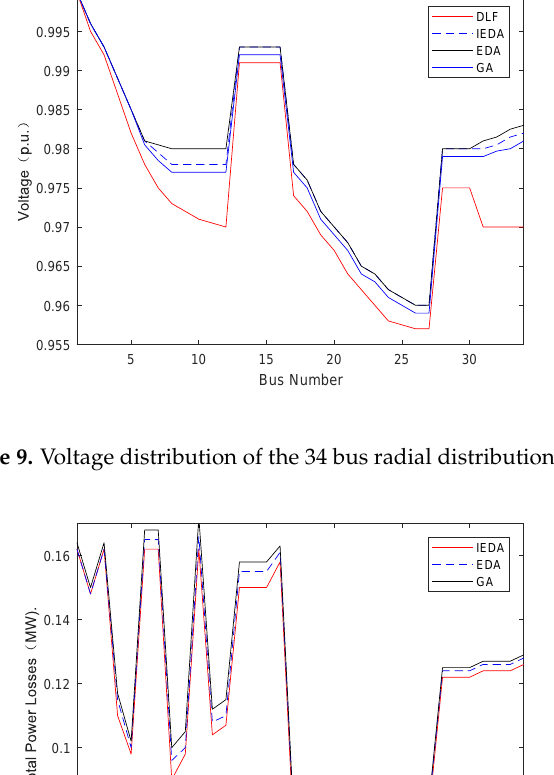
Figure 8. Evolution of the fitness function (total loss) with respect to number of generations for bus No. 21 in the 34 bus distribution test system.